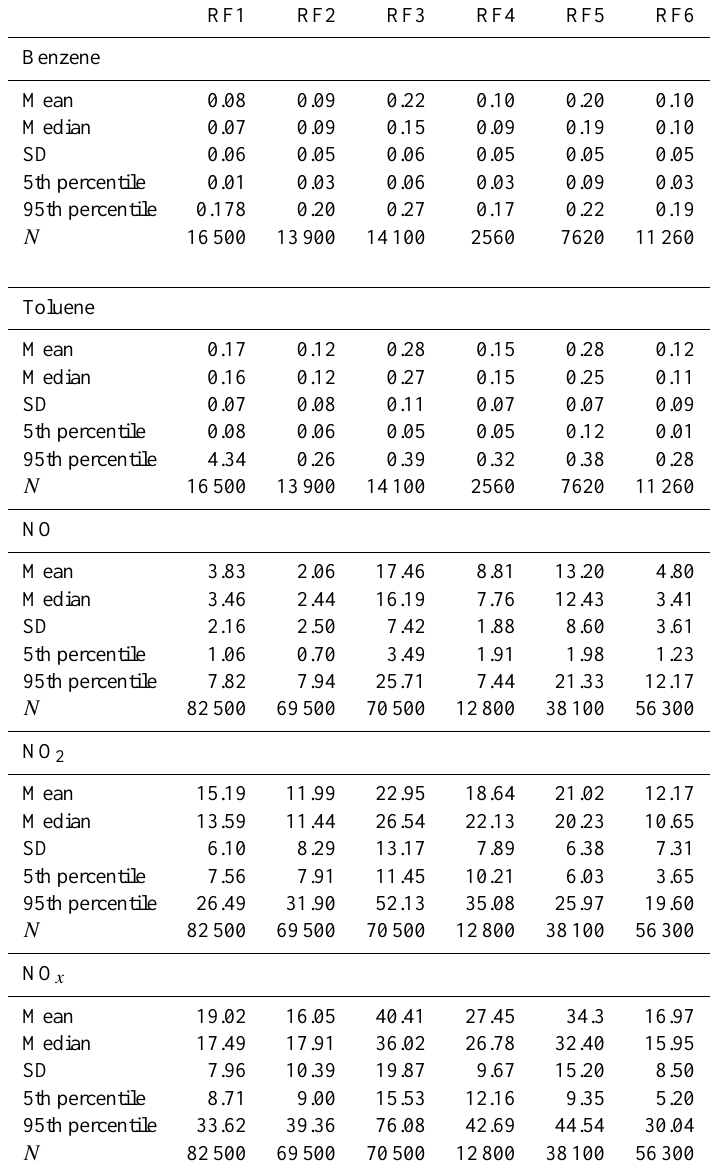
Table 2. Summary of mixing ratios (ppbv) observed over inner London during